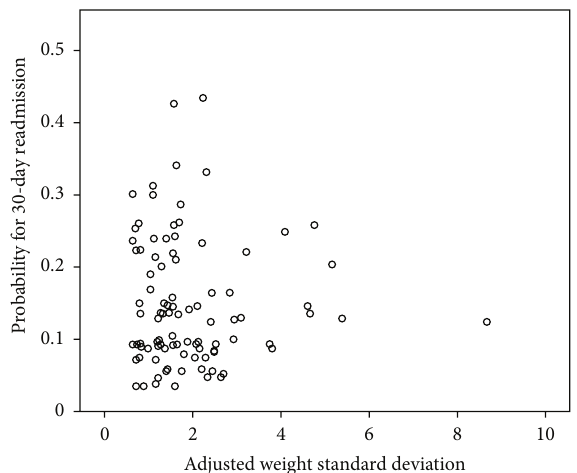
Figure 2: Scatterplot of 30-day readmission risk versus “adjusted weight standard deviation” for each